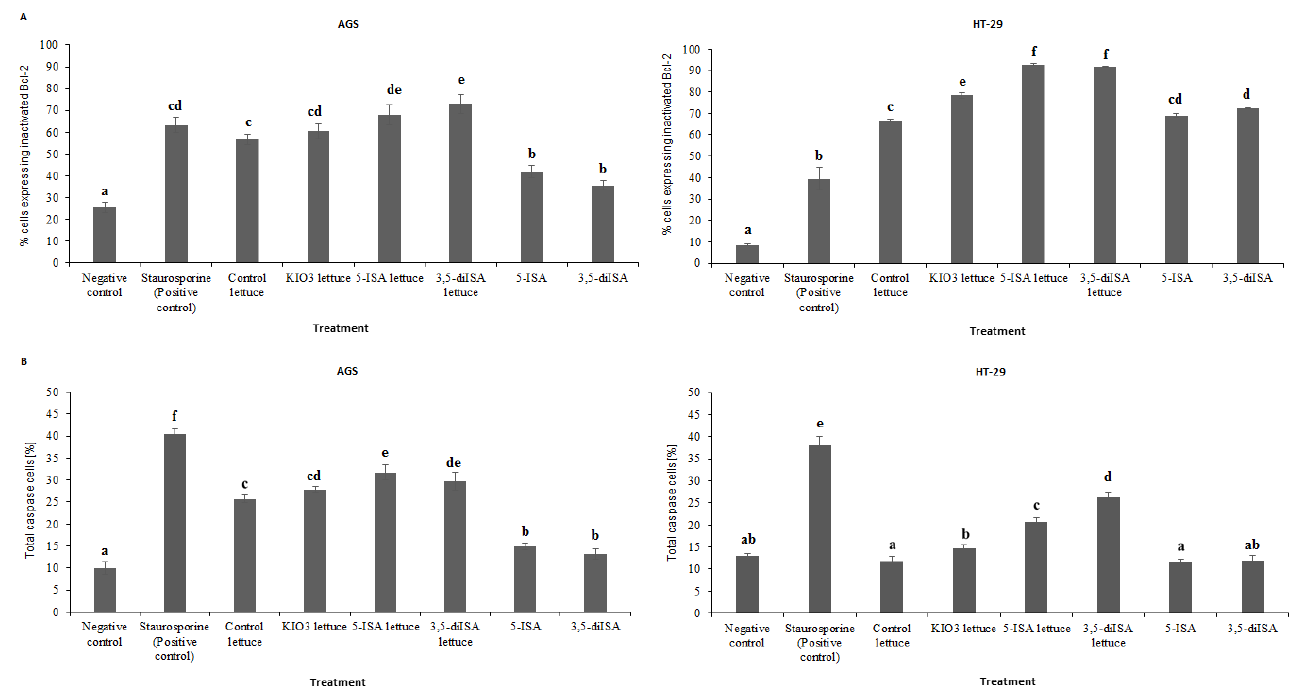
Figure 3. The effect of extracts from iodine-biofortified lettuce on Bcl-2 expression: inactivated cells ( A ) in human gastrointestinal cell line AGS and colorectal adenocarcinoma cell line HT-29. ( B ) The effect of extracts from iodine-biofortified lettuce on activity of caspases in human gastrointestinal cell line AGS and colorectal adenocarcinoma cell line HT-29. Cells were treated for 24 h with 1000 µg/mL extracts from control lettuce, or KIO3- fortified lettuce, or 5-ISA-fortified lettuce, or 3,5-diISA-fortified lettuce, or synthetic 5-ISA, or synthetic 3,5-diISA, or 1.5 µ M staurosporine as positive control. Statistical significance was assessed using one-way ANOVA followed by Tukey’s post hoc. Columns with the same letter are not significantly different ( p >